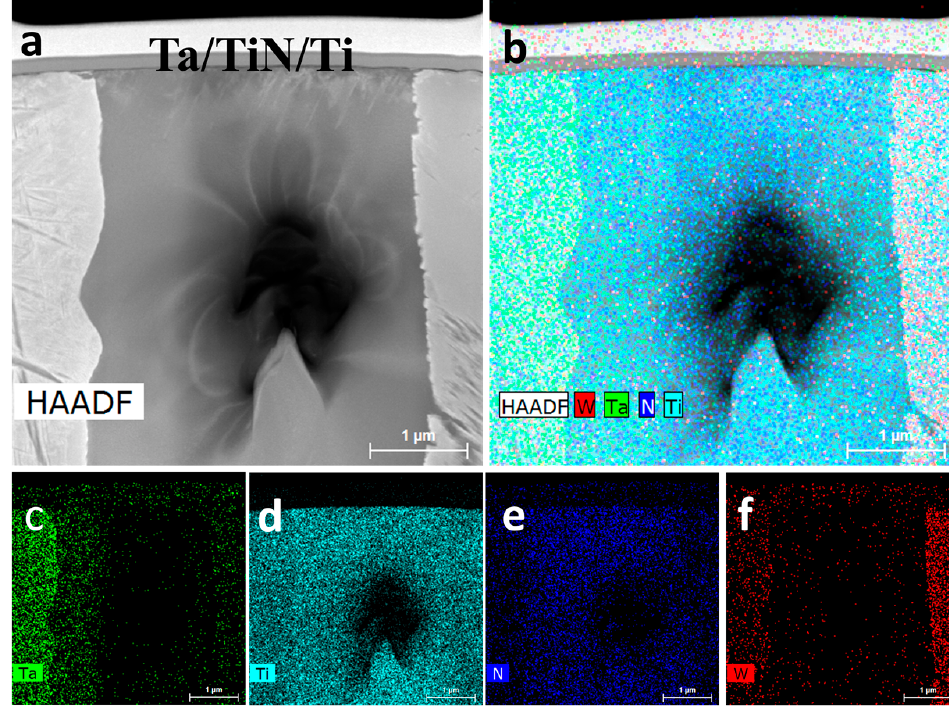
Figure 14. W/Ti/TiN/Ta-laminated composite joined at 1200 °C: ( a ) HAADF image; EDS mapping profile of ( b ) W, Ta, Ti, N, ( c ) Ta, ( d ) Ti, ( e ) N, and ( f ) W.